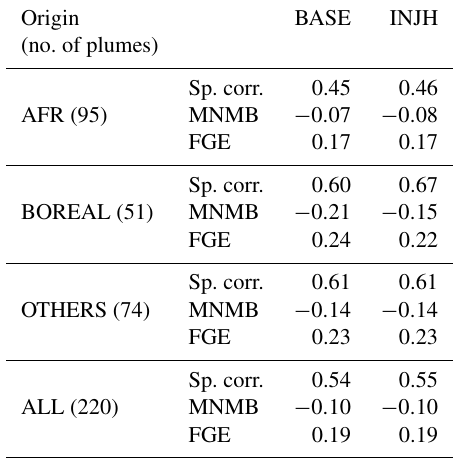
Table 3. Comparison of scores between the MOCAGE simulation and IAGOS measurements for the plume identified thanks to SOFT-